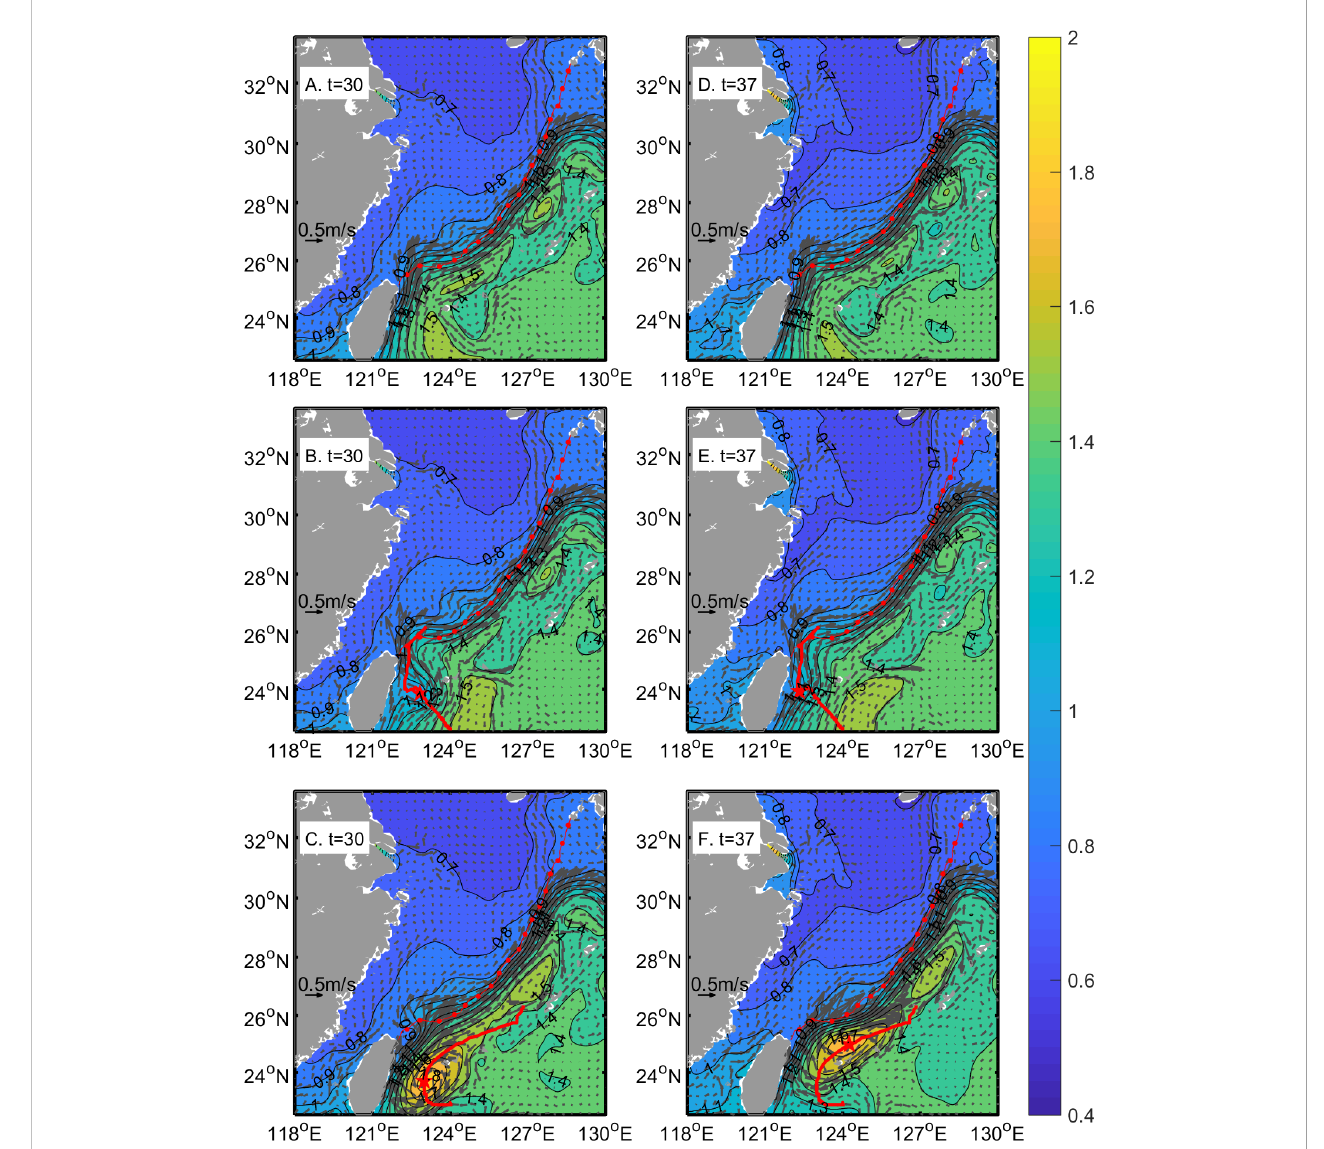
FIGURE 4 The sea surface height (m) and surface current fi elds in the (A, D) Ctrl, (B, E) CE, and (C, F) AE experiments at t=30 days and t=37 days. The dashed and solid red lines indicate the 200 m isobaths and the tracks of eddies, respectively. The red stars indicate the location of the eddy